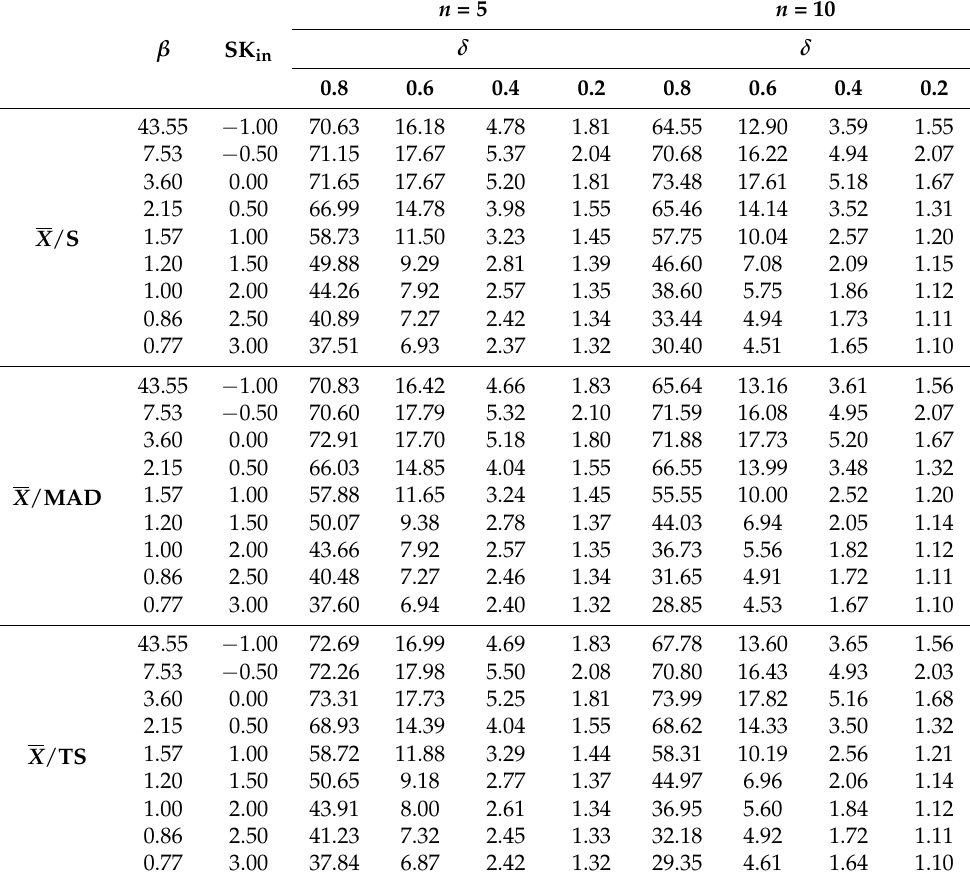
Table 8. ARL 1 values of the WV mean chart for different δ